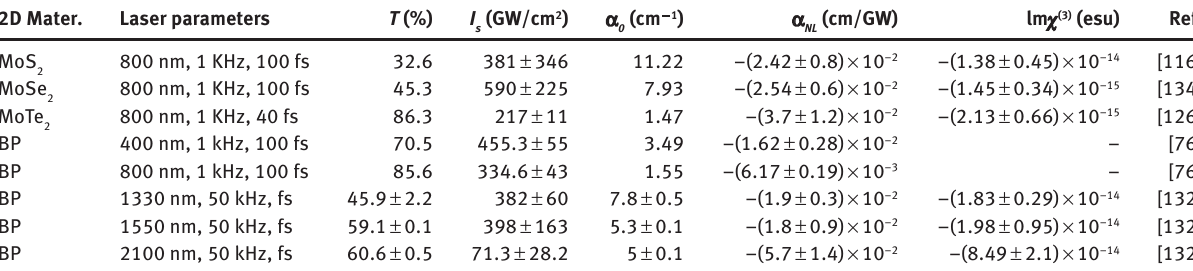
Table 1: Summarization of nonlinear optical properties of transition-metal dichalcogenides (TMDCs) and black phosphorus (BP). 2D